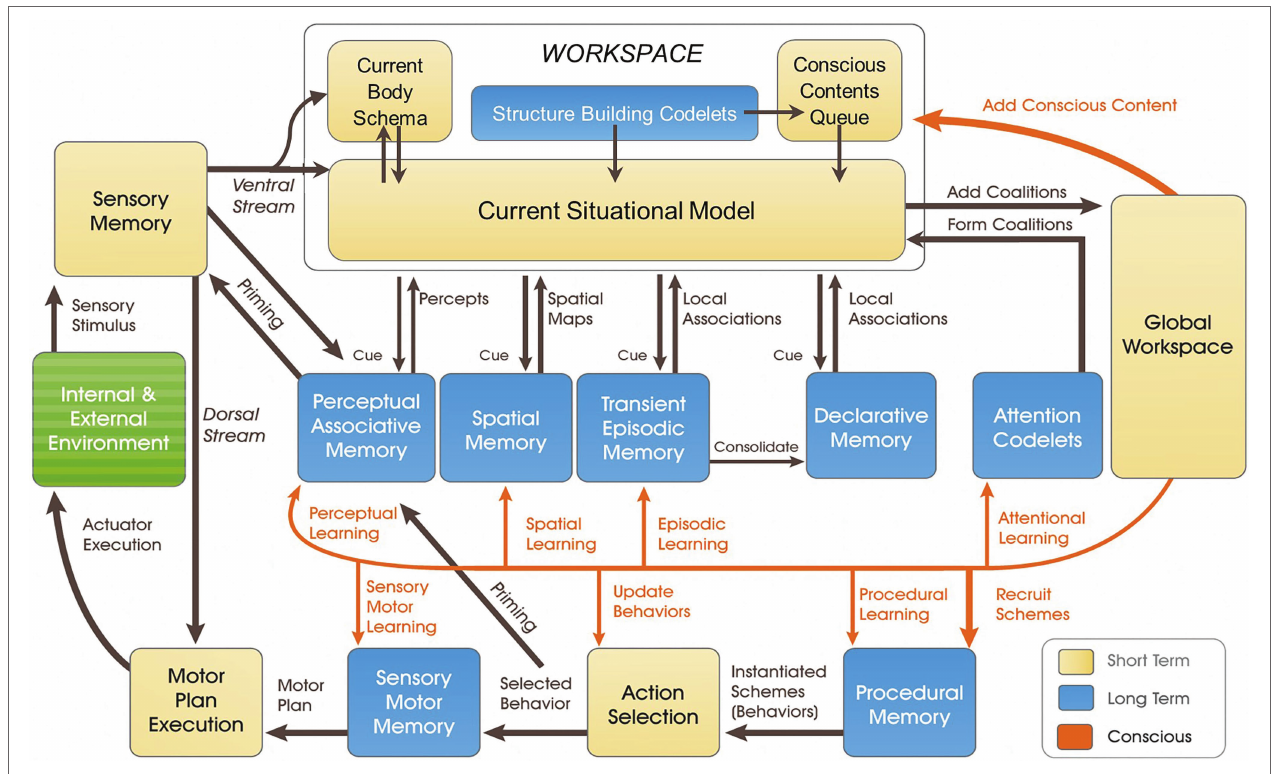
FIGURE 1 | The LIDA model cognitive cycle overview